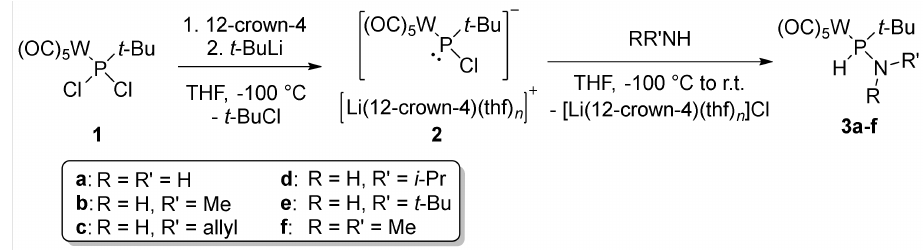
Table 1. Selected NMR data in THF and yields of synthesized aminophosphane complexes 3a – f . R R’ δ ( 31 P)/ppm 1 J W,P /Hz 1 J P,H /Hz 3a H